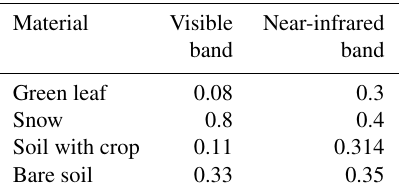
Table 6. The reflectivity of different surface coverings in the near- infrared and visible bands in the SiBcrop model. Material Visible Near-infrared band band Green leaf 0.08 0.3 Snow 0.8 0.4 Soil with crop 0.11 0.314 Bare soil 0.33